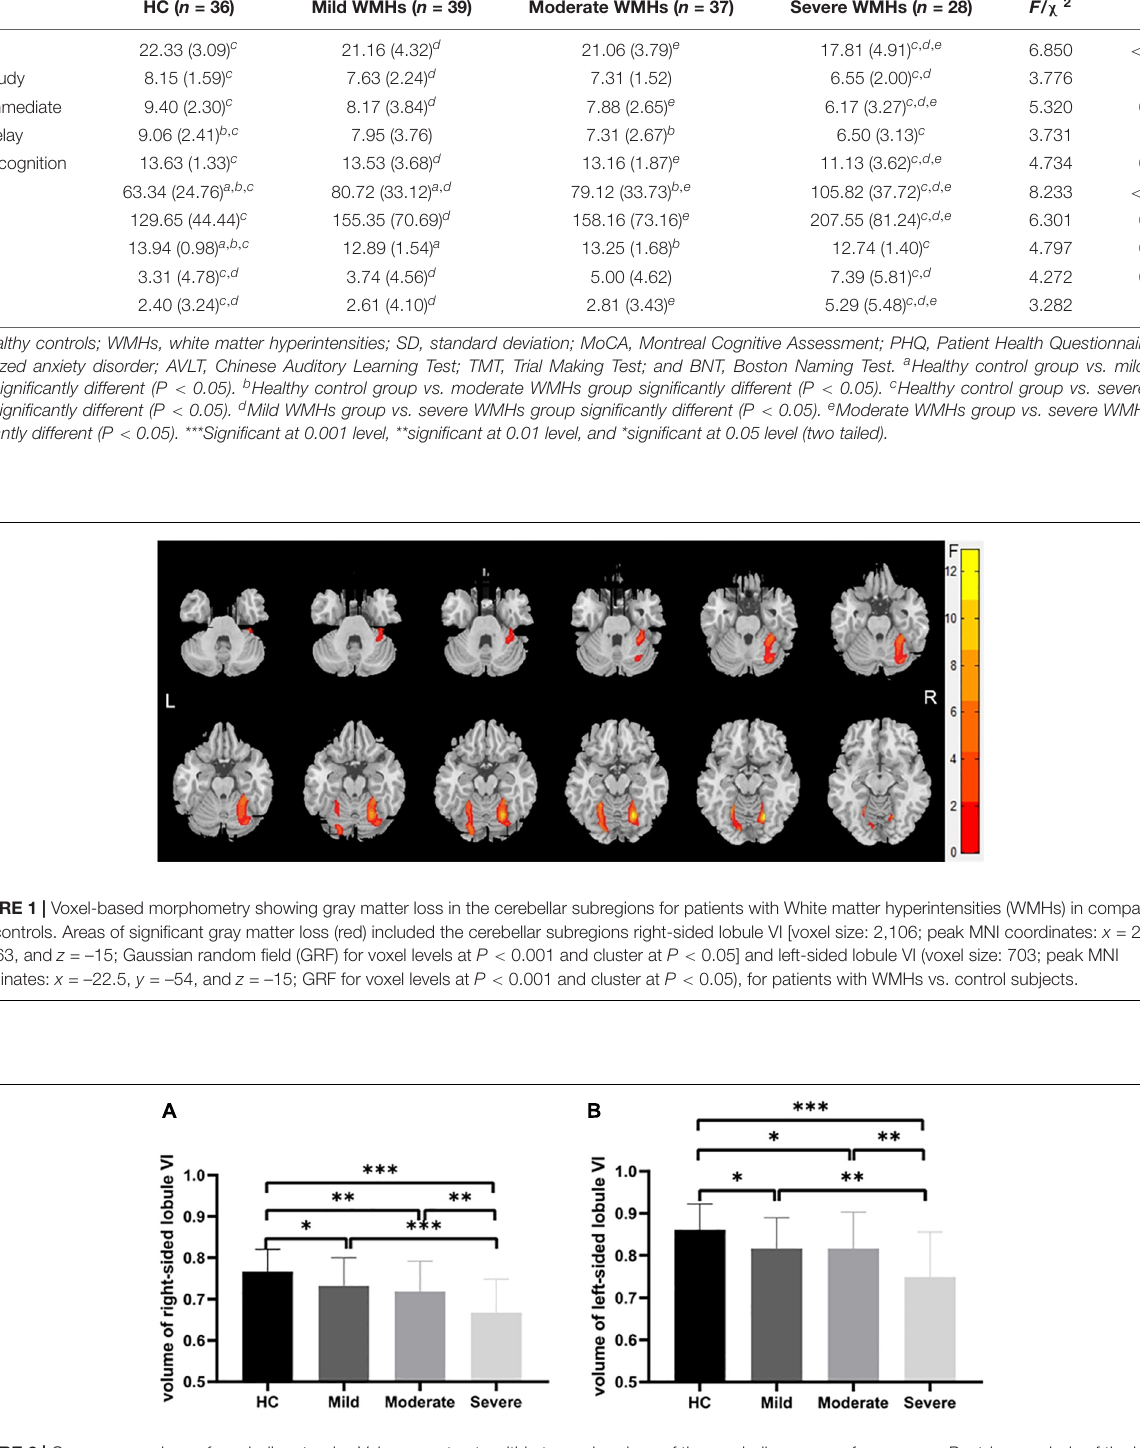
FIGURE 2 | Group comparison of cerebellar atrophy. Volume contrasts within two subregions of the cerebellum across four groups. Post-hoc analysis of the brain regions with significant differences among the four groups. (A) The gray matter volume (GMV) of the right-sided cerebellum lobule VI showing atrophy in WMHs groups. (B) The GMV of the left-sided cerebellum lobule VI showing atrophy in WMHs groups. ∗∗∗ P < 0.001, ∗∗ P < 0.01, and ∗ P < 0.05.